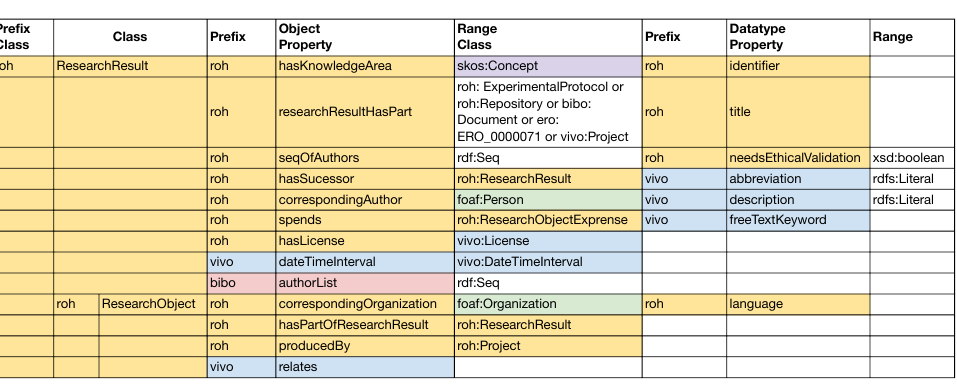
Figure 2. Excerpt from the ontology documentation for the roh:ResearchResult class and its sub- classes, adapted from the official ontology documentation